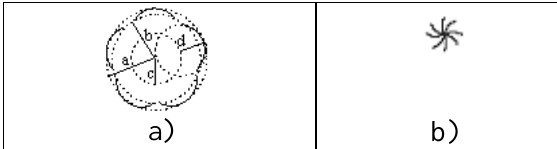
Fig 8. Topographic sign of the artesian water-supply pump 9. Ribos aiškumas . Sutartinis ženklas turi tur ė ti aišk ų kont ū r ą . Tod ė l jis tur ė t ų b ū ti sudarytas iš susiet ų